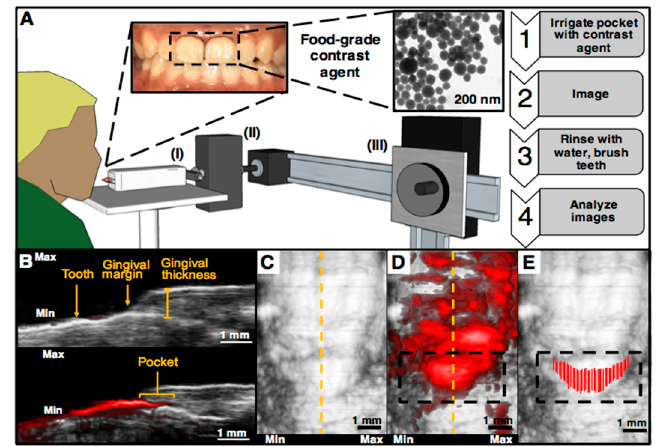
Figure 4. Representative human data of photoacoustic-ultrasound imaging for pocket depth measurements. ( A ) Overview of the imaging setup and methodology. The subject was seated in front of the transducer (I) and ultrasound gel was used for coupling. The stepper motor (II) was used for scanning the transducer and the sliding frame allowed positioning (III). First, the teeth of interest were irrigated with the contrast agent followed by imaging, removal of the agent, and image analysis. ( B ) A sagittal cross-section (dashed yellow line in Panel C) of a mandibular central incisor before (top) and after (before) irrigation with the contrast agent, revealing the pocket depth, measured from the gingival margin to the edge of photoacoustic signal. Nonspecific signal from the tooth, caused by the movement of coupling gel during scanning, did not contribute to the measurement. ( C ) A frontal view of the same tooth before ( D ) and after ( E ) irrigation. Nonspecific signal from contrast agent was removed during image processing by measuring the pocket from each sagittal plane as in Panel B and overlaying each measurement on the ultrasound-only image.